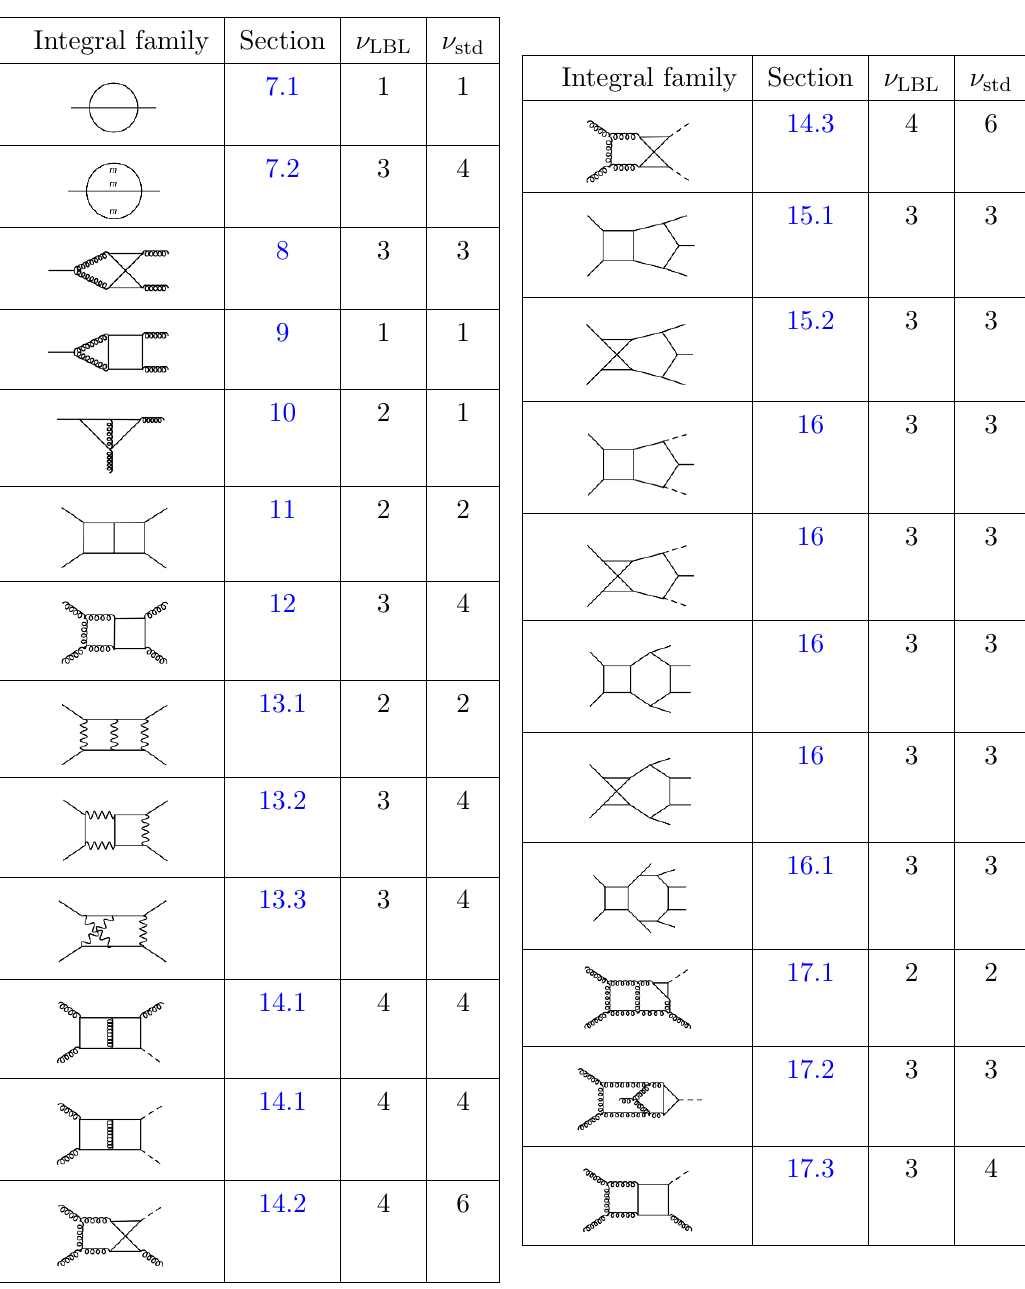
Table 1. Comparisons of the number of masters obtained by the LP criterion, from